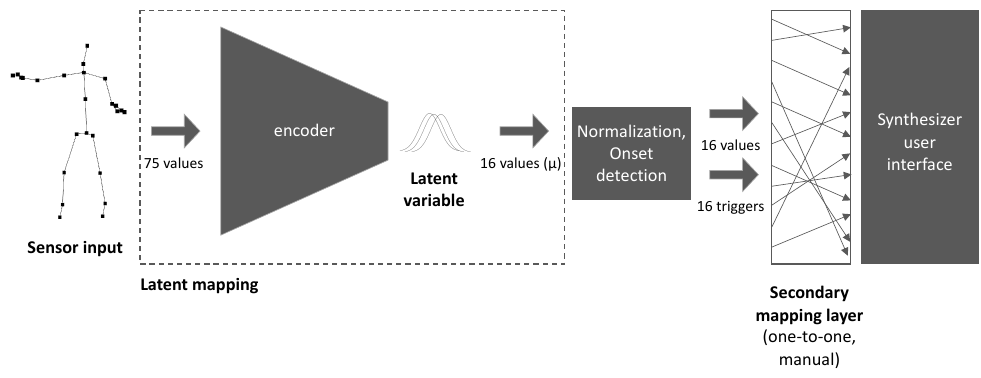
Figure 4. Data flow schematic of the Sonified Body